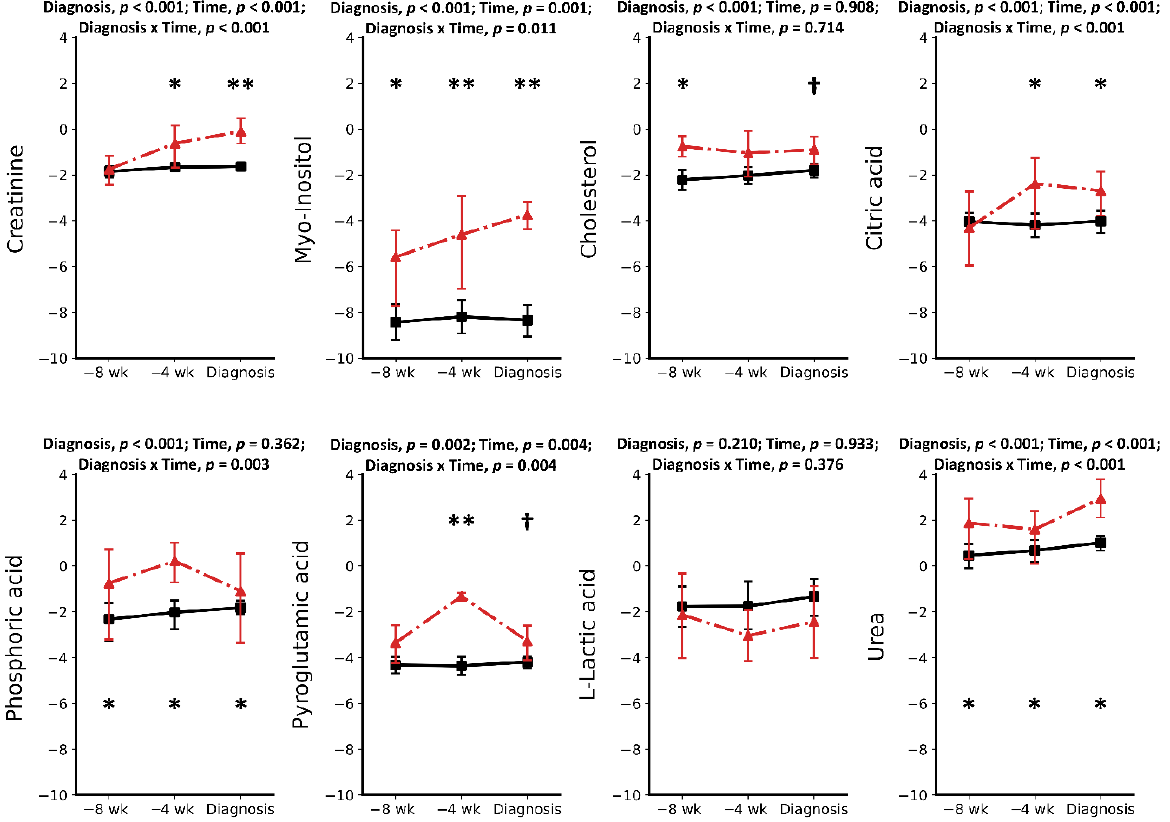
Figure 2. Concentrations of some of the serum metabolites detected in healthy cows (CON) (solid line) and pre-retained placenta or retained placenta (dashed) cows at − 8 and − 4 weeks prepartum and at the week of retained placenta diagnosis. Asterisks († p < 0.1; * p < 0.05; ** p < 0.001) indicate significant differences between groups at the respective time points. Results are presented in log2. Table 1. Concentrations of serum metabolites [mean(SD)] in healthy controls (CON) and pre-retained placenta (Pre-RP) cows at −8 weeks pre -partum as determined by GC/MS.